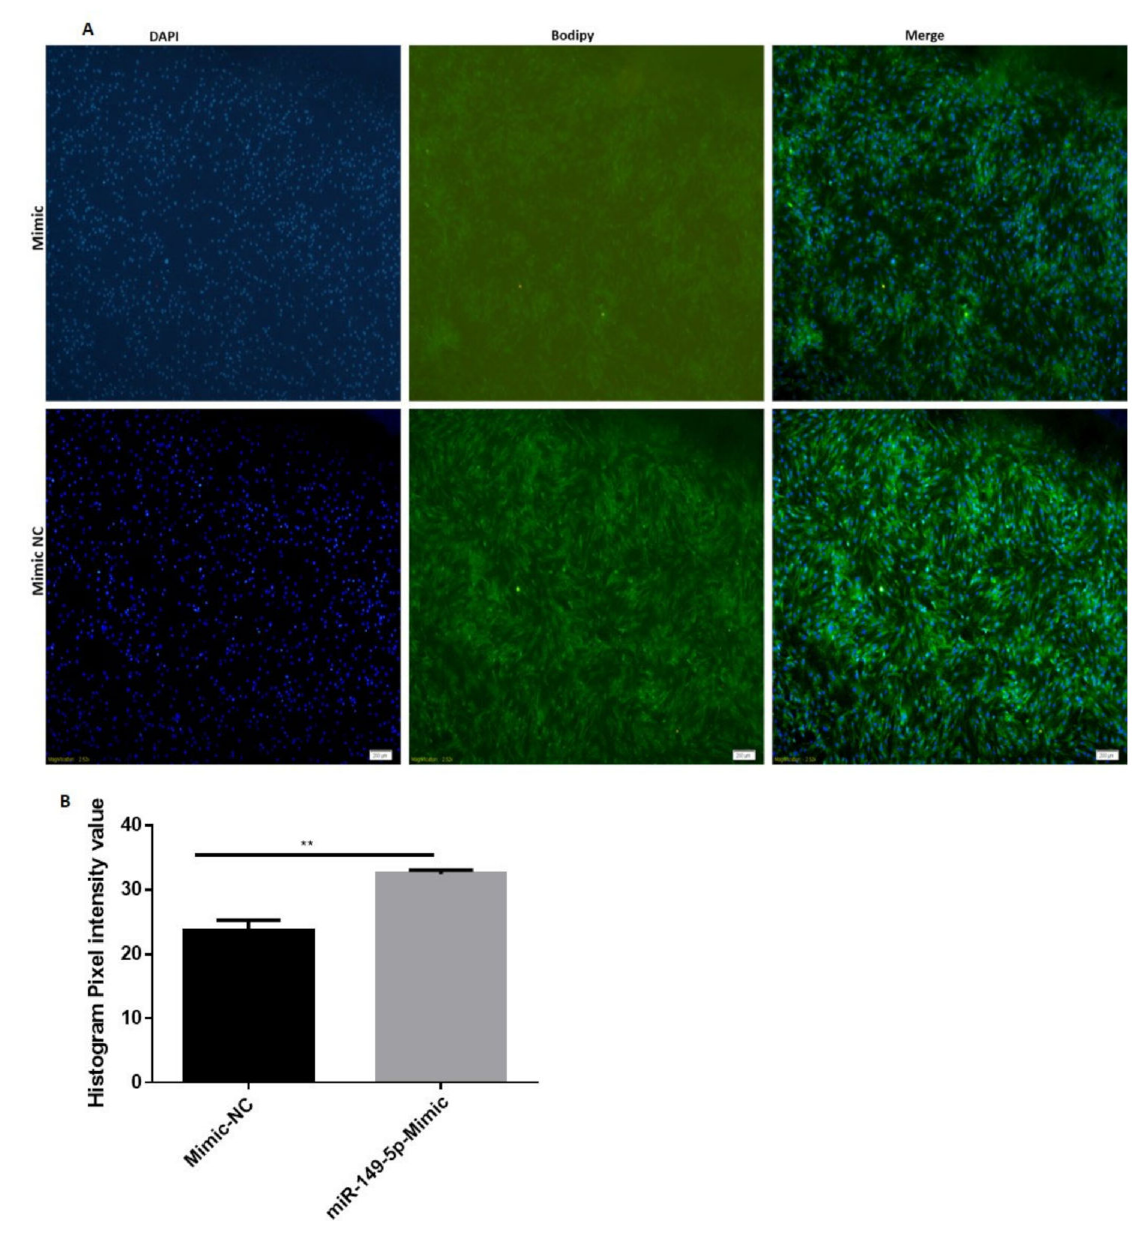
Figure 3. Bta-miR-149-5p represented bovine adipocyte differentiation. The photos were captured through an Olympus 1 × 71 microscope (Olympus, Tokyo, Japan). ( A ) The pictures of BODIPY-stained LDs in bovine adipocytes are represented in green, and the nuclei stained with 4, 6-diamidino-2-phenylindole (DAPI) are represented in blue. ( B ) The histogram pixel intensity values of adipocytes transfected with bta-miR-149-5p mimics or mimic NC. The values are presented with mean ± SEM, n = 3; ** p < 0.01 indicates statistical